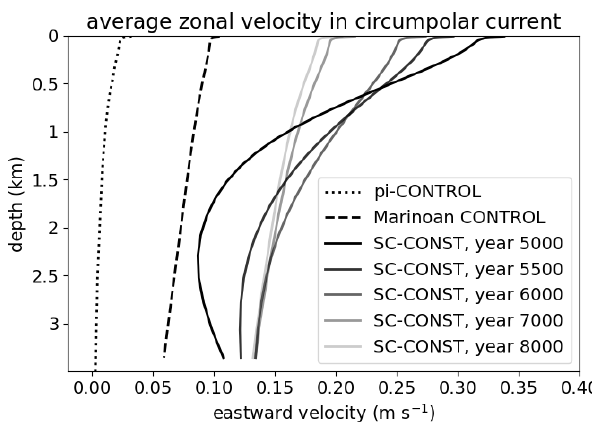
Figure 9. Vertical profiles of the zonally averaged eastward veloc- ity component over the region of the circumpolar current. Shown are profiles from the pre-industrial control simulation (dotted), the Marinoan control simulation (dashed) and the scenario SC-CONST (solid) for the same times as the sections shown in Fig. 5. In the Marinoan setup, we define the region of the circumpolar current as the latitudes between 45 and 75 ◦ N, and in the present-day con- figuration the current is averaged over the latitudes between 75 and 45 ◦